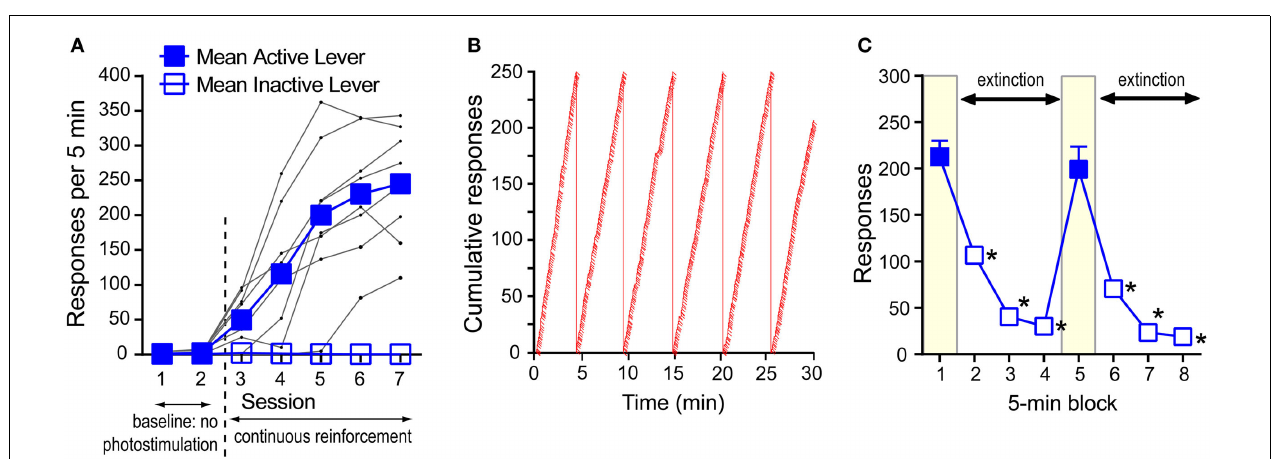
perievent spike rasters (top) and histograms (bottom) show photo stimulation-evoked firing of a neuron. Experimenter administered 20 photo trains (PD: 1ms; PI: 0.2mW; PN: 8) of the 20- (left), 50- (middle), and 100-Hz (right) frequencies with the inter-train intervals varying between 10 and 15s. Bin = 5ms. (B’) It shows an enlarged histogram for the 100-Hz train. Bin = 2ms.